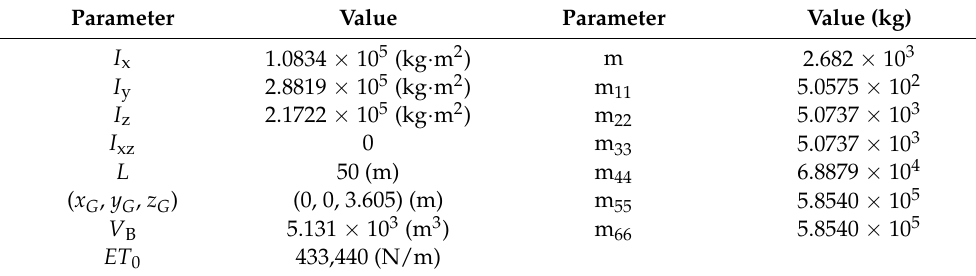
Table 1. Structure parameters for the studied